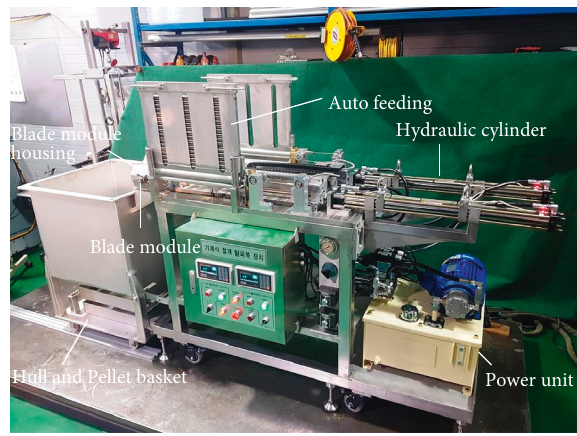
Figure 20: Practical scale mechanical